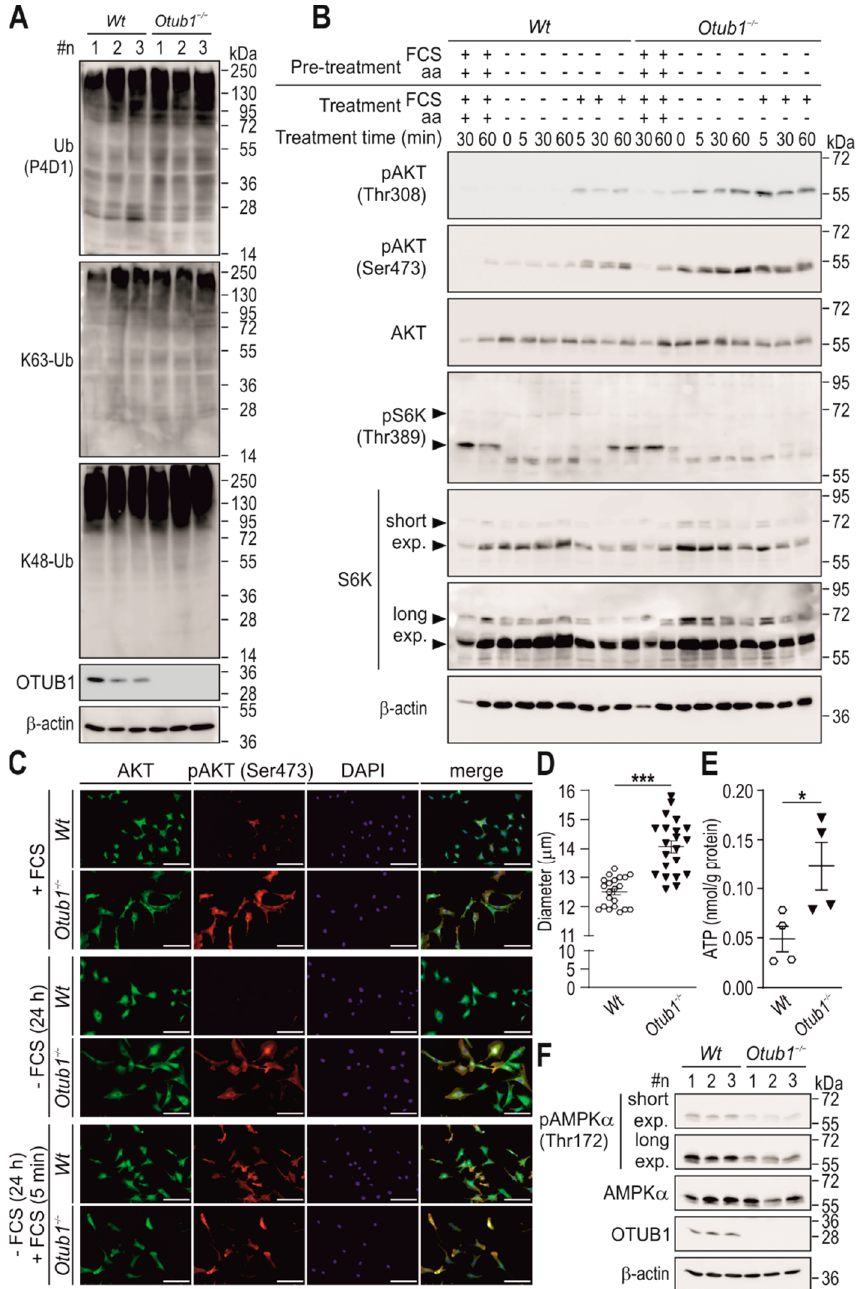
Figure 3. AKT/mTOR signaling in Otub1 − / − MEFs. ( A , B ) Immunoblotting of the indicated (phos- pho)proteins in mouse embryonic fibroblasts (MEFs) derived from wild-type ( Wt ) and constitutive Otub1 homozygous KO ( Otub1 − / − ) mice ( n = 3). K63-Ub, K63-linked ubiquitin (Ub) chains; K48-Ub, K48-linked Ub chains; FCS, fetal calf serum; aa, amino acids; pre-treatment: 4 h. ( C ) Immunofluo- rescence of the indicated (phospho)proteins in MEFs of the indicated genotype. Scale bar, 150 μ m. ( D ) Analysis of the cell diameter of Wt and Otub1 − / − MEFs. Each dot ( n = 21) represents the analysis of 315 to 1197 single cells. ( E ) Intracellular ATP levels normalized to total protein content of MEFs ( n = 4). ( F ) Immunoblotting of the indicated (phospho)proteins in Wt and Otub1 − / − MEFs (AKT, green; pAKT (Ser473), red; DAPI, blue). exp, exposure time. Representative images are shown and data are presented as the mean ± SEM. Full-length immunoblots are shown in Figures S3–S5. *, p < 0.05; ***, p < 0.001 by two-tailed Student’s t -test.